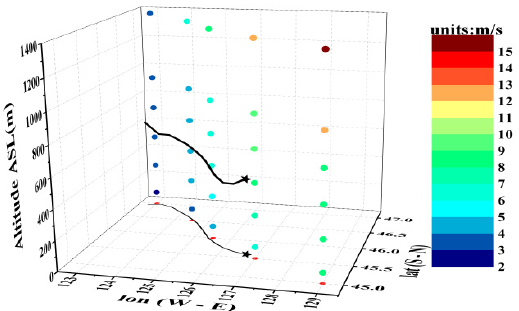
Figure 7. The FNL horizontal wind speed at 14:00 on the vertical section near the projected point of the backward trajectory of the last 13 h (the black thick line is the backward trajectory. The red dots and black thin line are the projection of the trajectory on the xOy plane. The black star is the starting point of the trajectory).